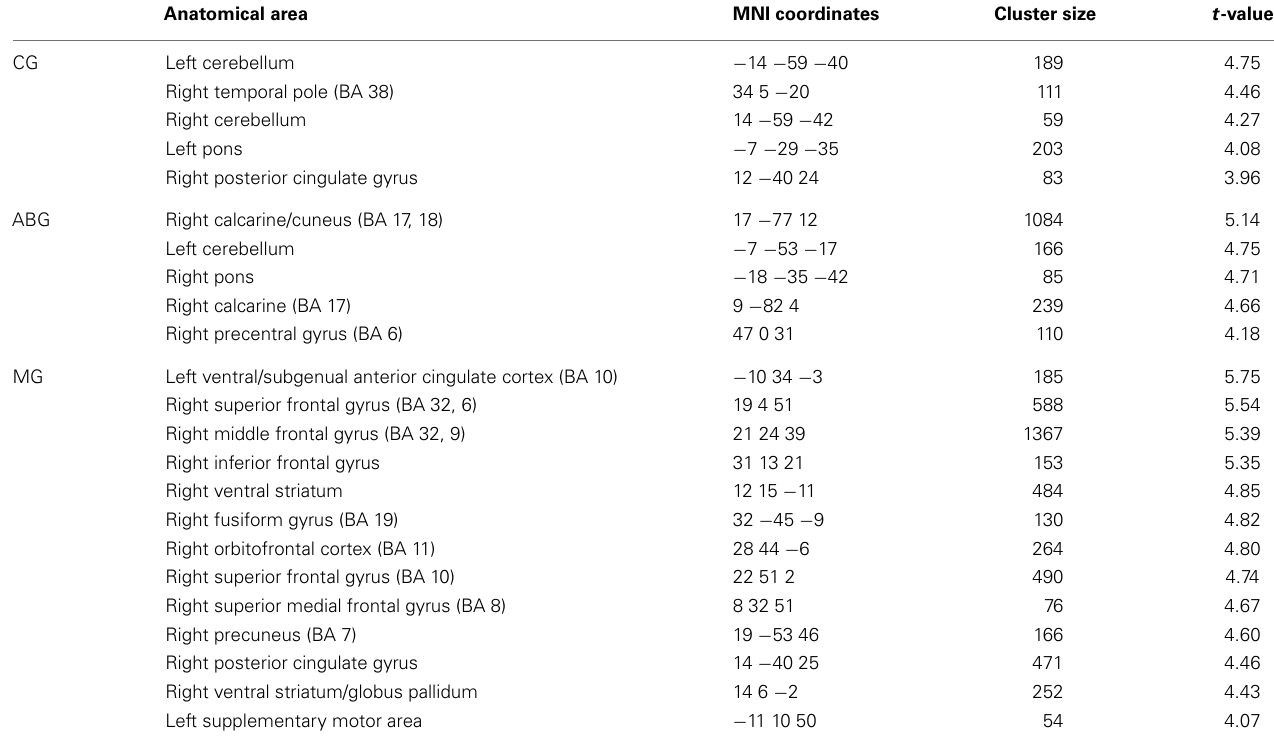
Table 3 | GMV increases (6-month − acute) in LHD patients ( n =